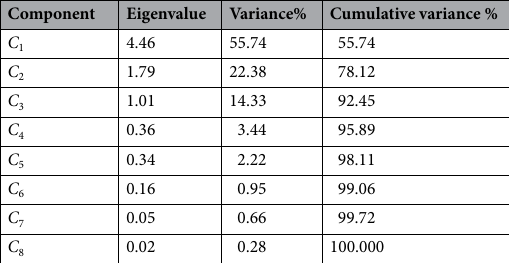
Table 6. Cumulative variance of the principal